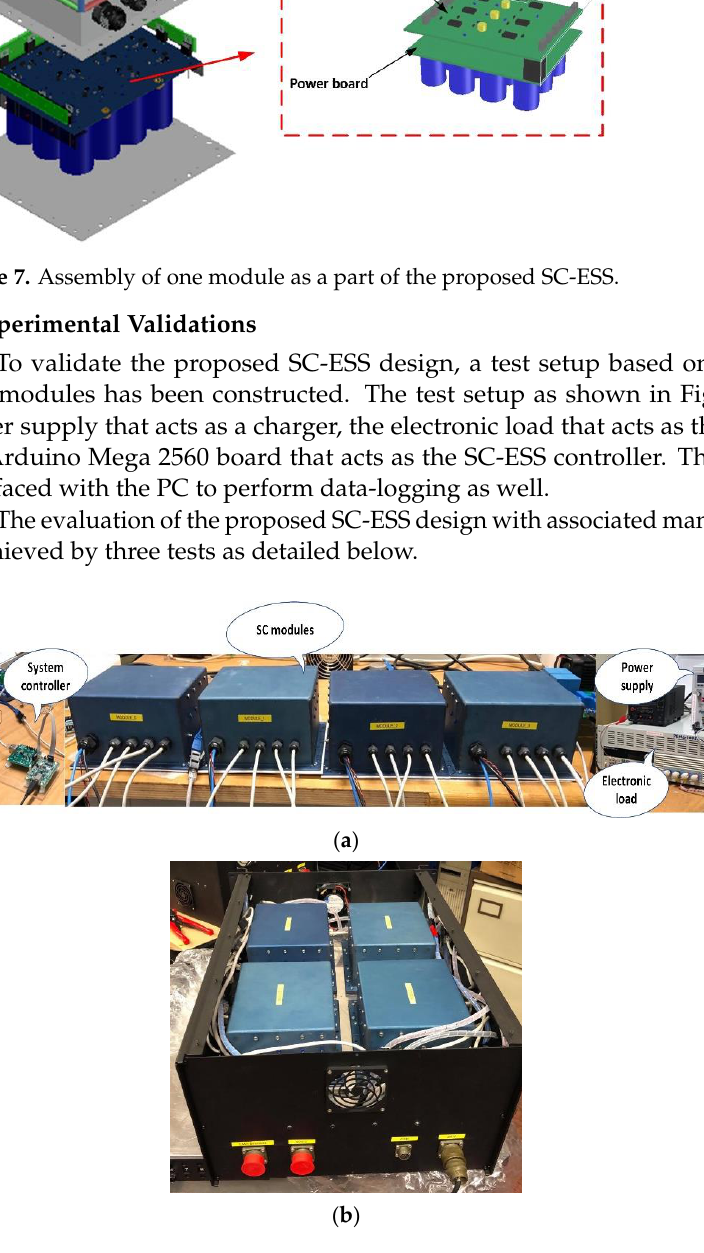
Figure 8. Experimental setup to validate the proposed design for SC-ESS: ( a ) test setup; ( b ) assem- bled SC-ESS